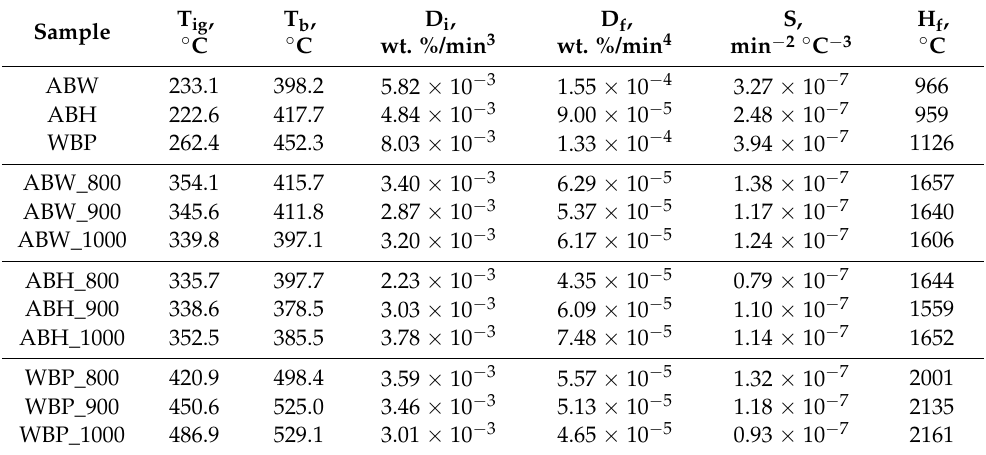
Table 4. Key combustion